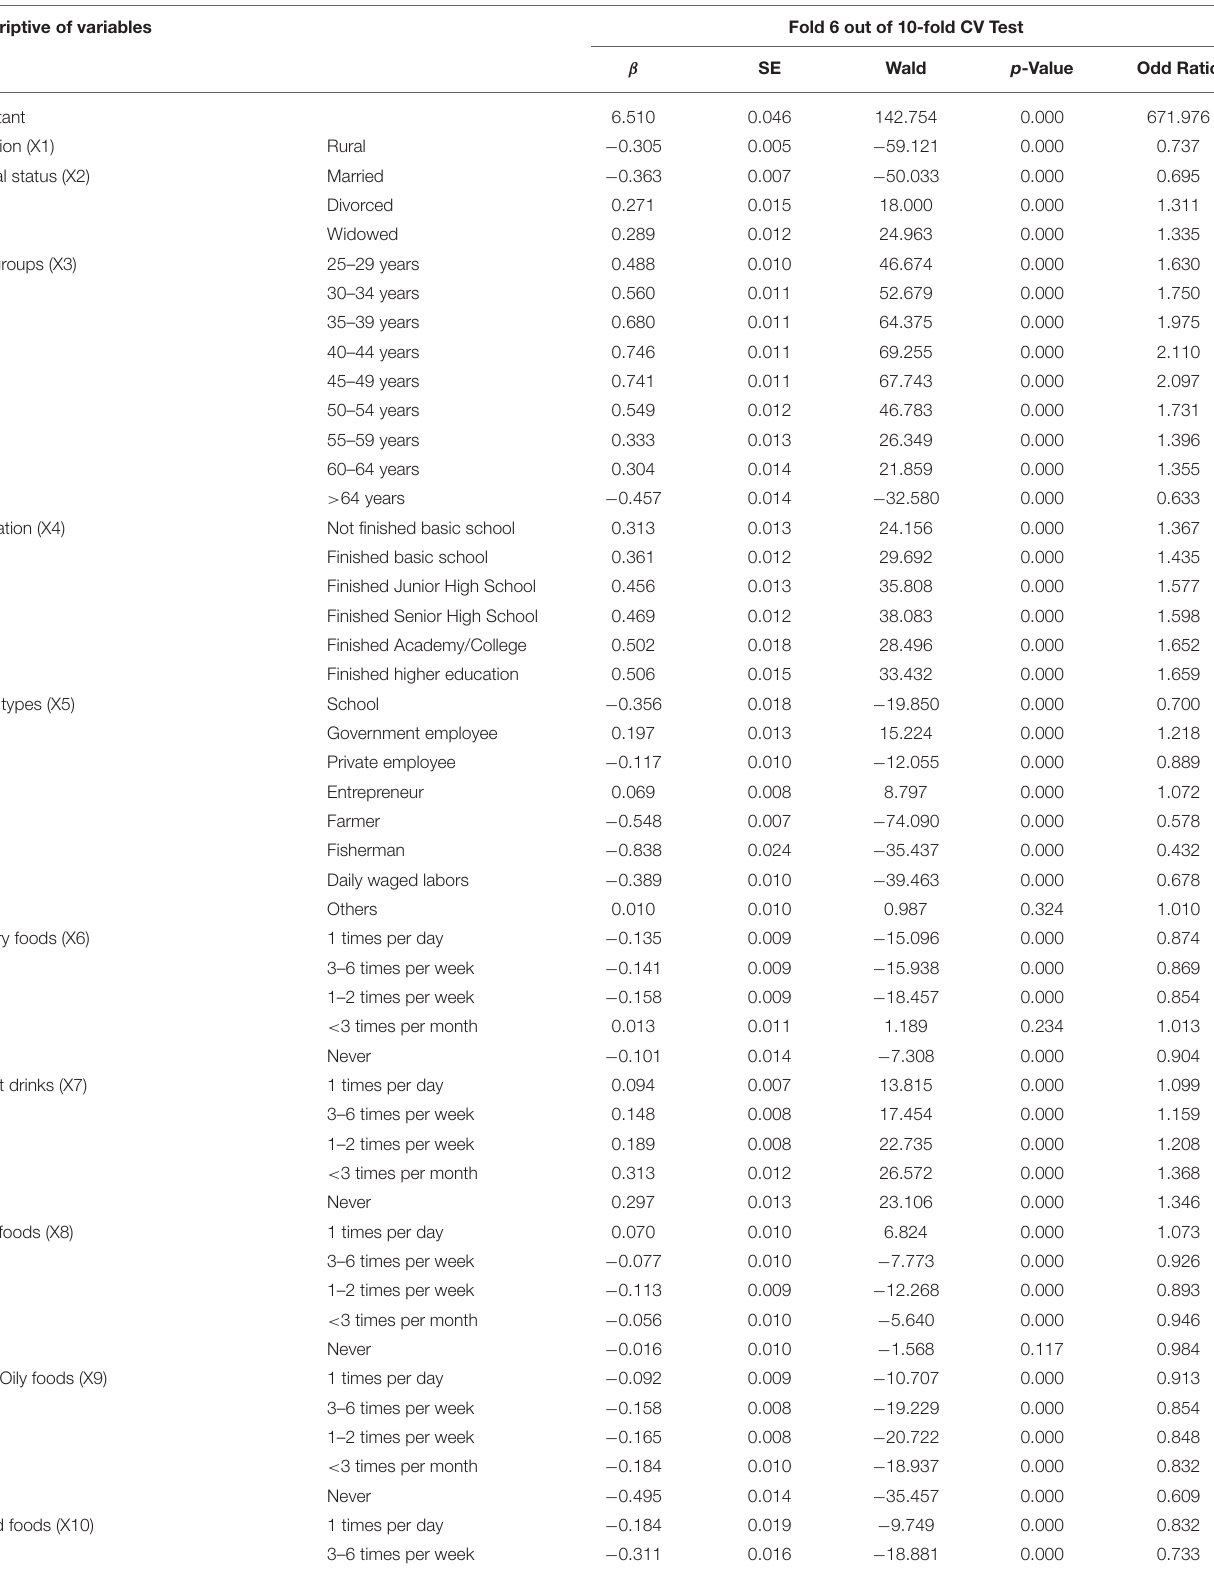
TABLE 4 | Estimation of the Logistic Regression parameters based on fold 6 out of the 10-fold CV for obesity dataset in Indonesian RISKESDAS 2018 survey. Descriptive of